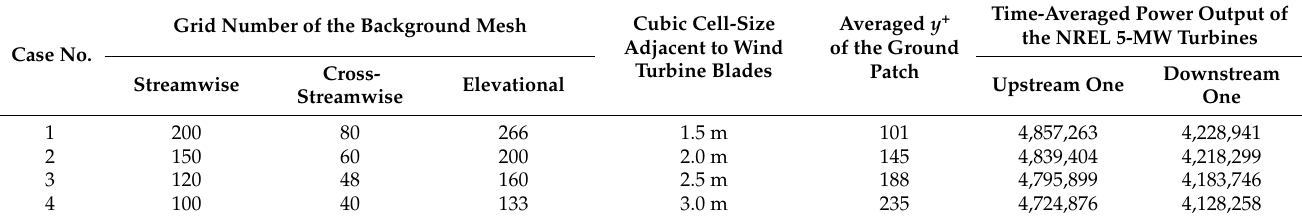
Table 3. Parameters and results of the mesh-independence analysis.